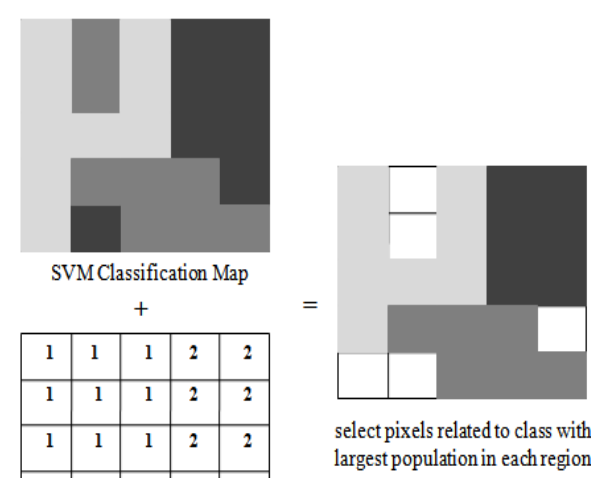
Figure 2. Schema of the proposed method.